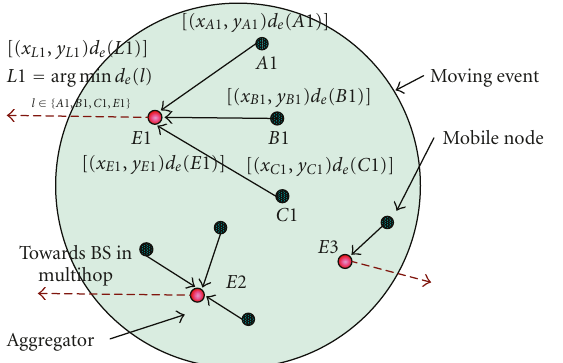
Figure 5: Aggregation in the event region in